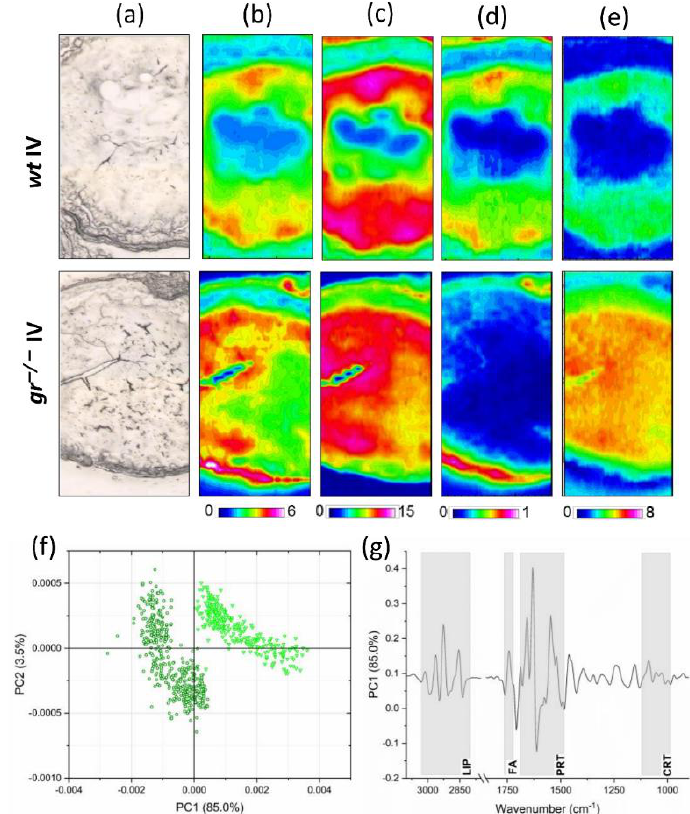
Figure 4. Hyperspectral imaging analysis. ( a ) Microphotographs of class IV oocytes isolated from wt and gr − / − ovaries; false color images showing the topographical distribution of ( b ) lipids (color scale 0–6), ( c ) proteins (color scale 0–15), ( d ) glycosylated compounds (color scale 0–1), and ( e ) cortisol (color scale 0–8) (the dimensions of false color images were 164 × 492 µ m). PCA score plots of ( f ) wt IV (light green) and gr − / − IV (dark green) spectral data; PC1 loadings of ( g ) wt IV / gr − / − IV spectral